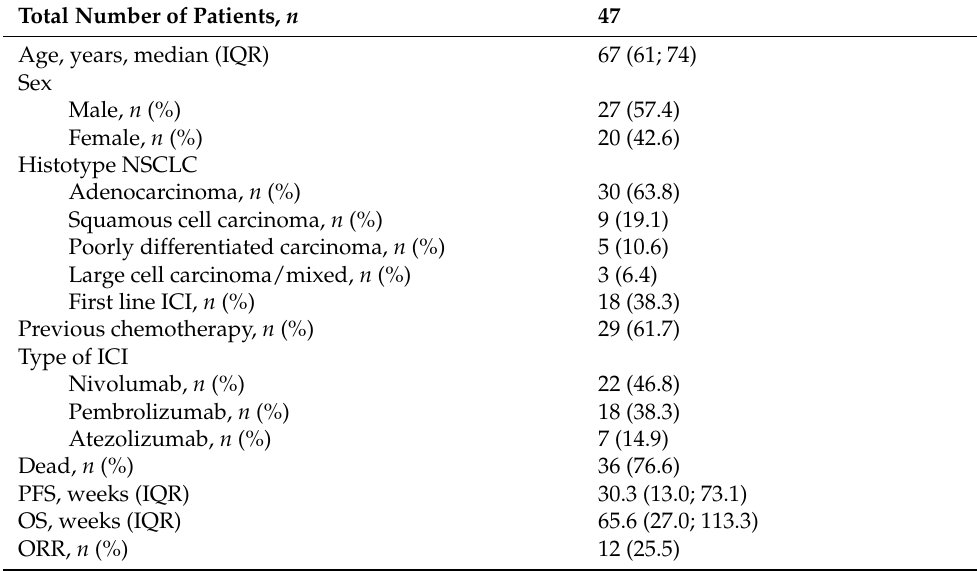
Table 1. Baseline characteristics of the study population. Continuous variables are expressed in median